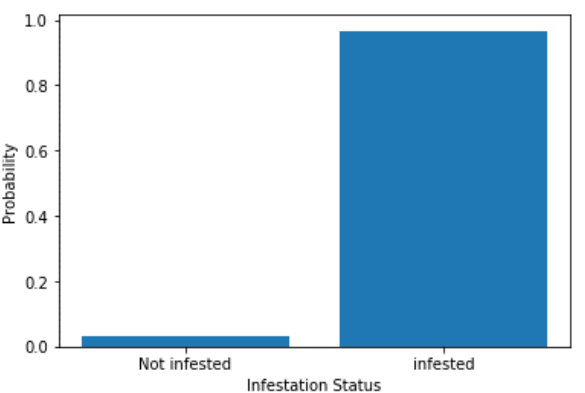
Figure 9. Infestation state of a tree after examining the folder no. 33 of the provided database containing 753 recordings spanning several days. The probability is derived by averaging the probabilities of all cases and normalizing to